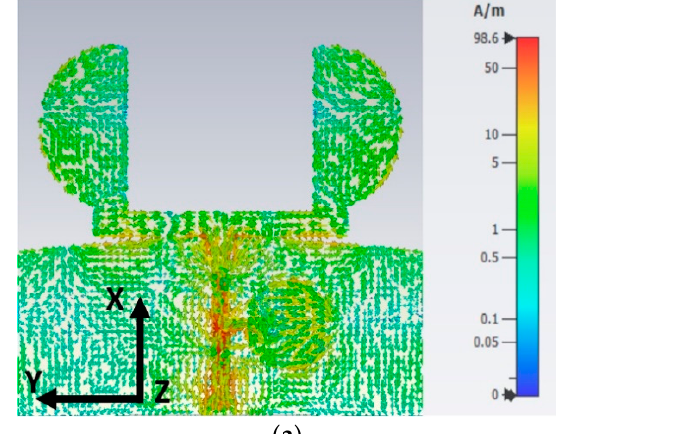
Figure 12. Simulated realized gain and radiation efficiency of the modified UWB antenna array with and without BPF.